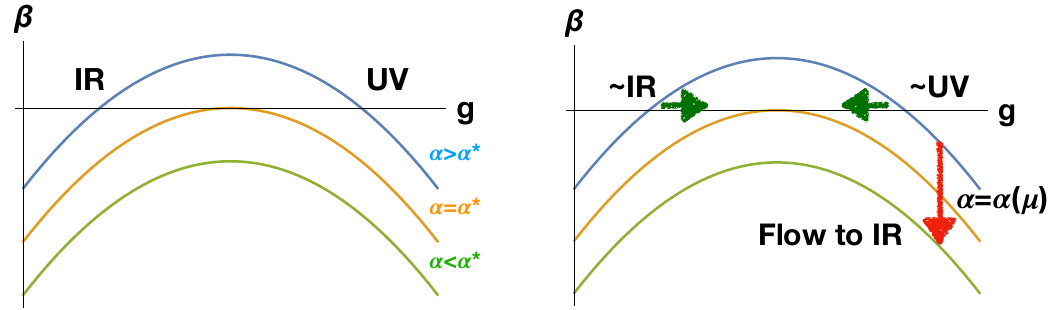
Figure 9. Here we show a cartoon of an approximate CFT dual of our 5D model. On the left is the picture of (cid:12)xed points annihilating under continuous variation of some descriptor of the theory, as explored in [8]. On the right is our picture of quasi-(cid:12)xed points annihilating under renormalization group